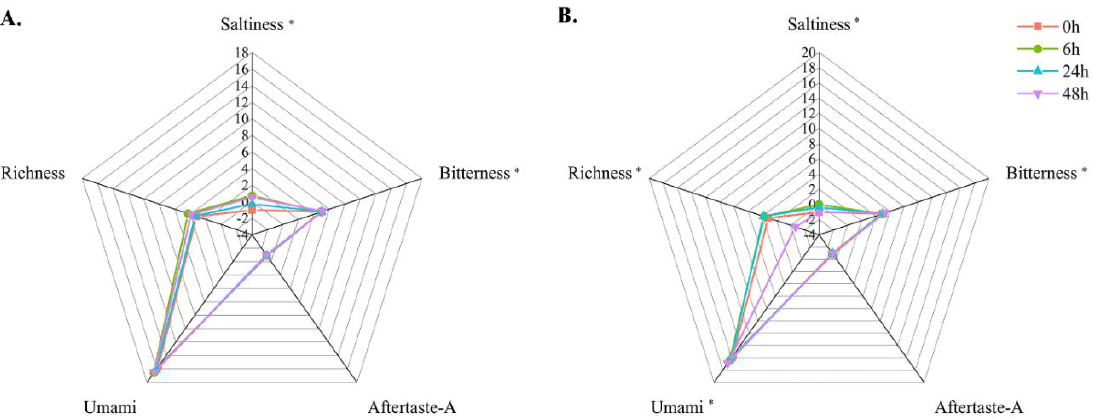
Figure 3. Radar chart of electronic tongue taste profiles of American shad muscle 24 °C ( A ) and 4 °C ( B ) during storage. Aftertaste-A: astringent aftertaste. * indicates significant differences at different storage times ( p < 0.05).